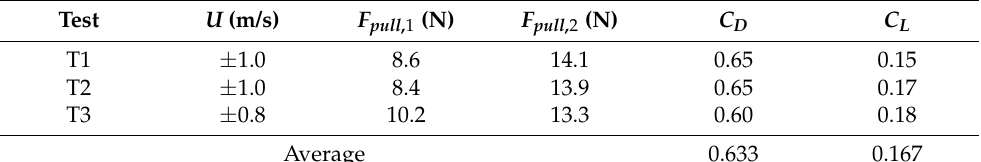
Table 2. Measured pulling forces and calculated force coefficients. (ACM s g = 3.23, 𝜇 = 0.25). Test 𝑼 (m/s) F pull, 1 (N) 𝑭 𝒑𝒖𝒍𝒍,𝟐 (N)